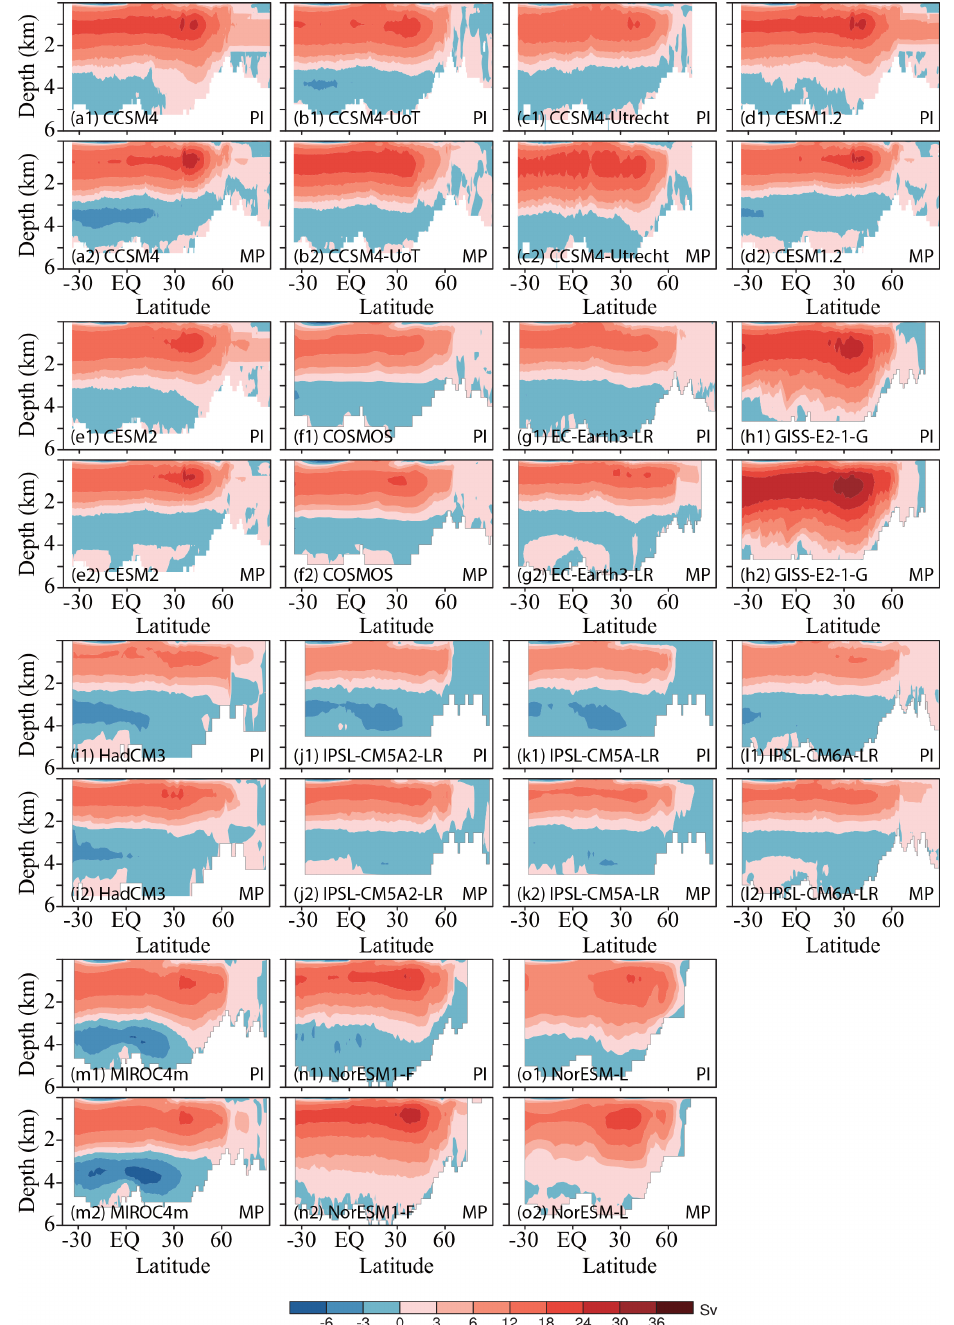
Figure 1. The simulated AMOC (unit: Sv) in PlioMIP2. “PI” denotes pre-industrial, and “MP” denotes mid-Pliocene.